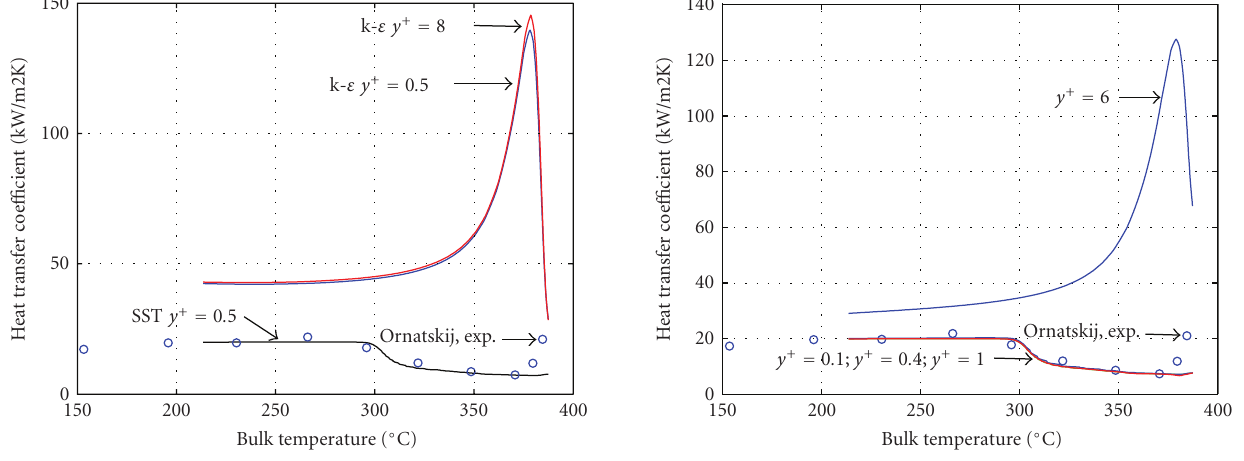
Figure 1: Comparison of SST turbulence model, k- ε model and experiment by Ornatskij et al. [3]. Flow conditions: p = 25 . 5 MPa, d = 3 mm, G = 1500 kg / m 2 s, q = 1810 kW / m 2 , vertical upward flow in a pipe.